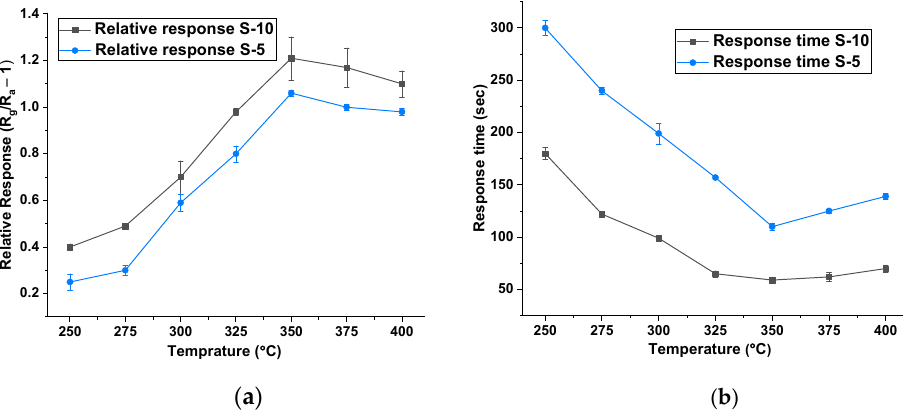
Figure 3. ( a ) Temperature vs. relative response of S-10 and S-5 NiO at 10% r.h. ( b ) Temperature vs. response time of S-10 and S-5 NiO at 10% r.h.